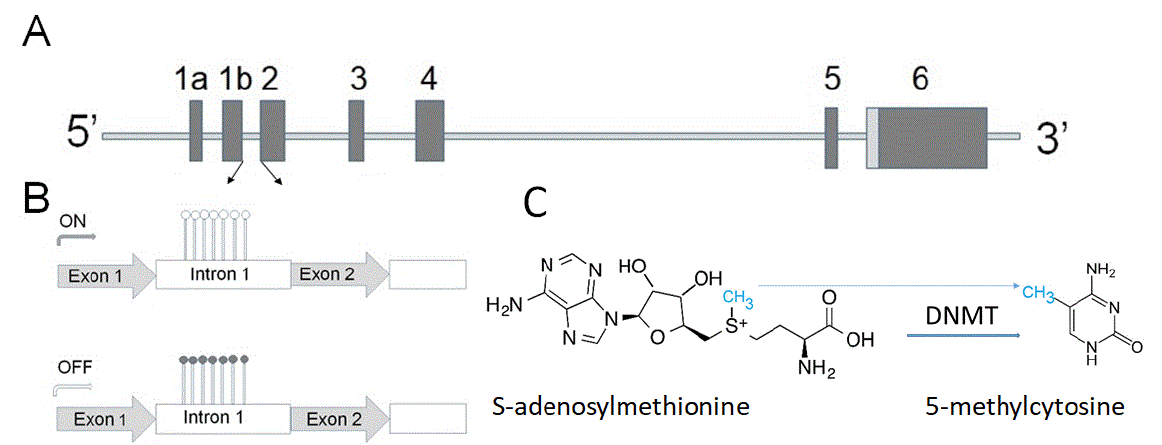
Figure 1. ( A ) Human α -synuclein gene contains six exons shown as vertical bars. The translation start codon ATG is located in exon 2. The sequence between two arrows contains a high density of CpG bases, which can be methylated ( B , C ). ( B ) Upper panel shows a small level of methylation (open circles) within the α -synuclein intron 1 region, allowing a high level of the gene expression (ON). Lower panel-methylation of cytosine residues (closed circles) downregulates expression of the α -synuclein gene. ( C ) DNA methylation catalyzed by methyltransferases (DNMTs) converts cytosine to 5-methylcytosine by transfer of methyl group from S-adenosylmethionine. This is one of several epigenetic mechanisms to control gene expression.